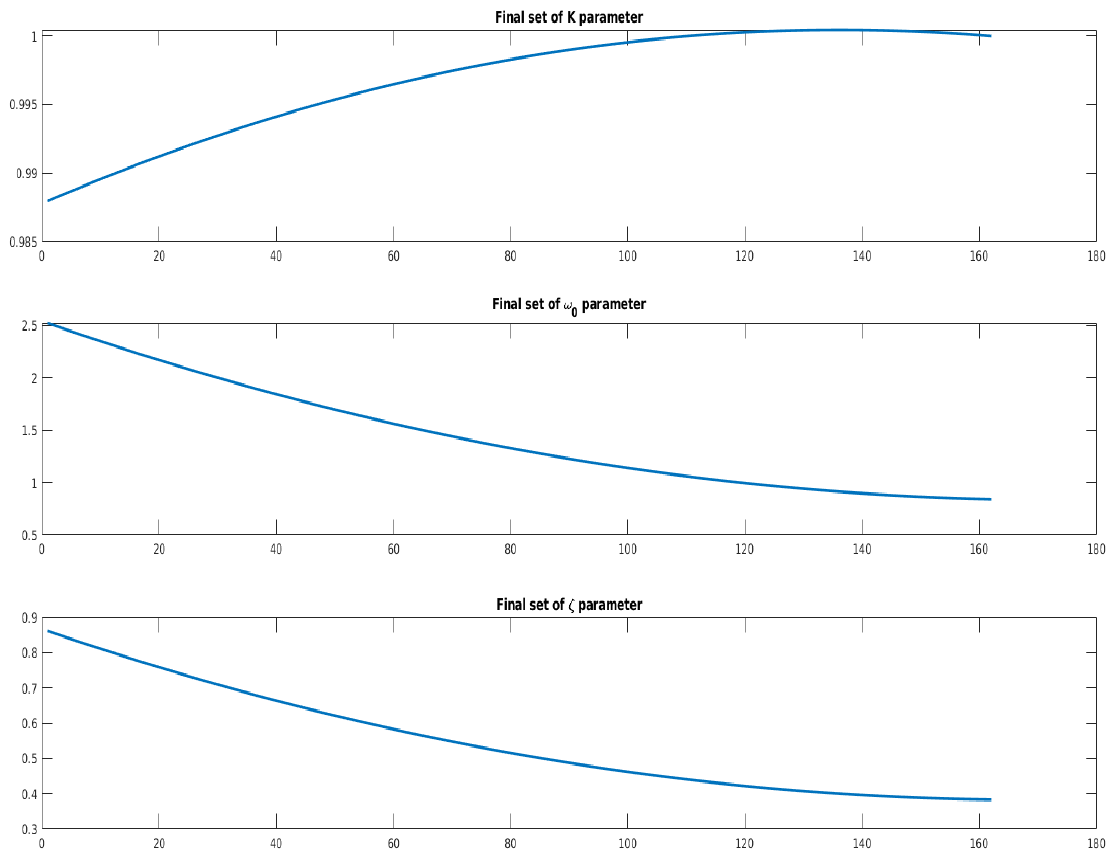
Figure 8. The sets of time-varying coefficients ensuring the reduction of the settling time of the oscillatory system with ζ =3.83 · 10 − 1 , ω 0 = 8.41 · 10 − 1 , k = 1, and t s = 1/10 s.